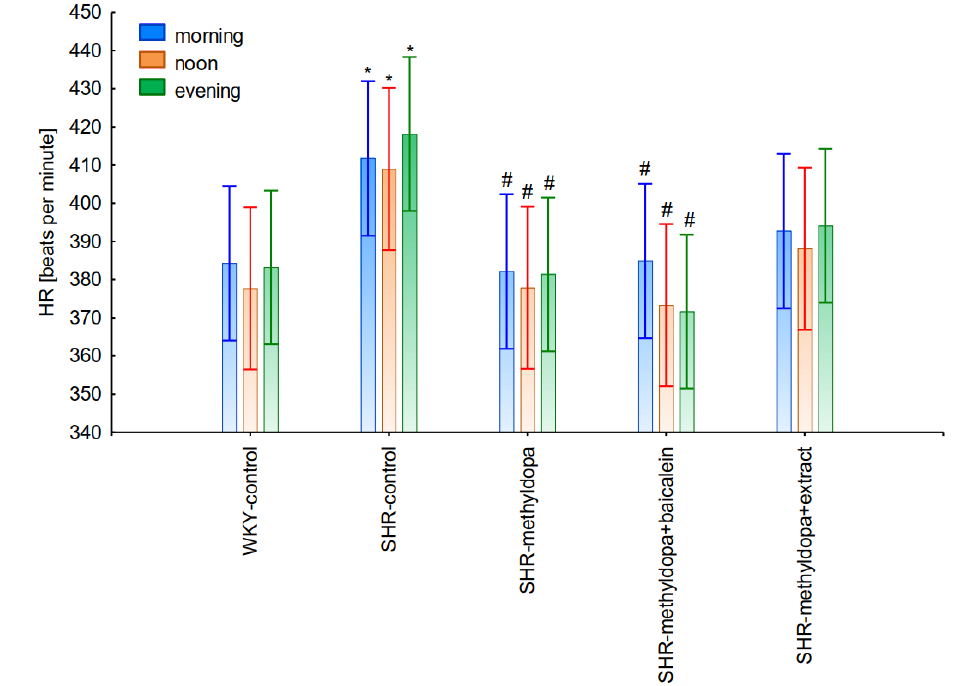
Figure 12. Changes in heart rate (HR) after administration of methyldopa and its combination with baicalein and Scutellaria baicalensis root extract with regard to the time of day of administration in SHR pregnant rats. Legend: n = 10, mean ± SEM; * — vs. proper WKY control, p < 0.05; # — vs. proper SHR control, p < 0.05; & — vs. proper SHR-methyldopa, p < 0.05. However, further analysis showed that no effect of the day of administration was noted in the investigated groups (for SBP: ANOVA II: F(2, 120) = 0.01, p > 0.05; for DBP: ANOVA II: F(2, 120) = 0.448, p > 0.05; and for HR: ANOVA II: F(2, 120) = 0.441, p > 0.05). It was also found that administration of methyldopa as well as the combination of the com- pound or the extract with methyldopa significantly reduced SBP and DBP, and these ef- fects were exacerbated by administration of methyldopa with baicalein in relation to me- thyldopa alone ( p < 0.05). During HR measurements, the administration of methyldopa as well as the combination of the compound (but not the extract) with methyldopa signifi- cantly reduced the parameter. These effects were not affected by administration of me- thyldopa with the extract in relation to methyldopa alone ( p > 0.05). 2.3. Body Mass The body mass of the animals was measured at the beginning of substance admin- istration and on the last day of the experiment. During the entire experiment, statistically significant overall variability was observed (ANOVA II — total effect: F(4, 47) = 41.7, p < 0.0001; time effect: F(1, 47) = 622.0, p < 0.0001; and interaction: F(4, 47) = 44.1, p < 0.0001). It was noted that at the beginning of the experiment all SHR rats had significantly lower ( p < 0.05) body masses than the WKY control rats (Figure 13). At the end of the experiment, the weight of the animals increased significantly in all groups ( p < 0.05), although the SHR control rats still weighed less than the WKY control, and the administration of all sub- stances significantly inhibited the increase in body mass of the animals, although the type of substance administered was not a differentiating factor.